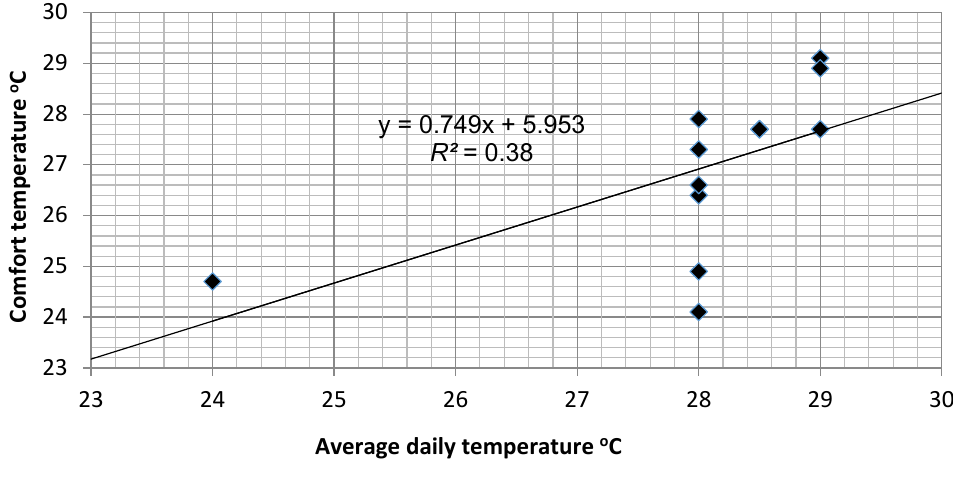
Figure 1. Comfort temperature line generated from some previous comfort studies in